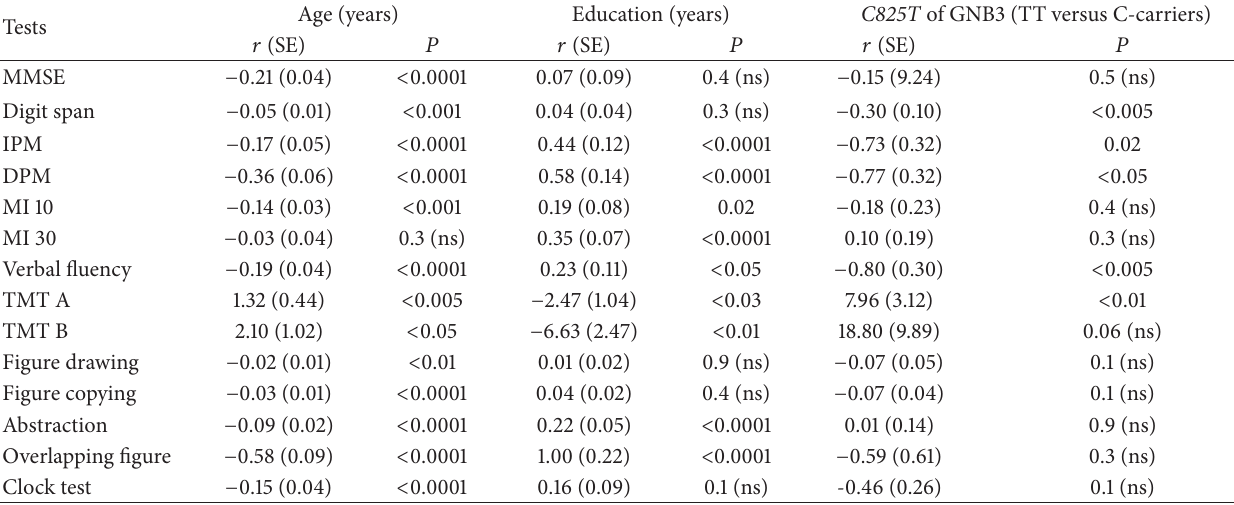
Table 3: Multiple regression of the neuropsychological tests with age, education, and C825T polymorphism of GNB3 gene.